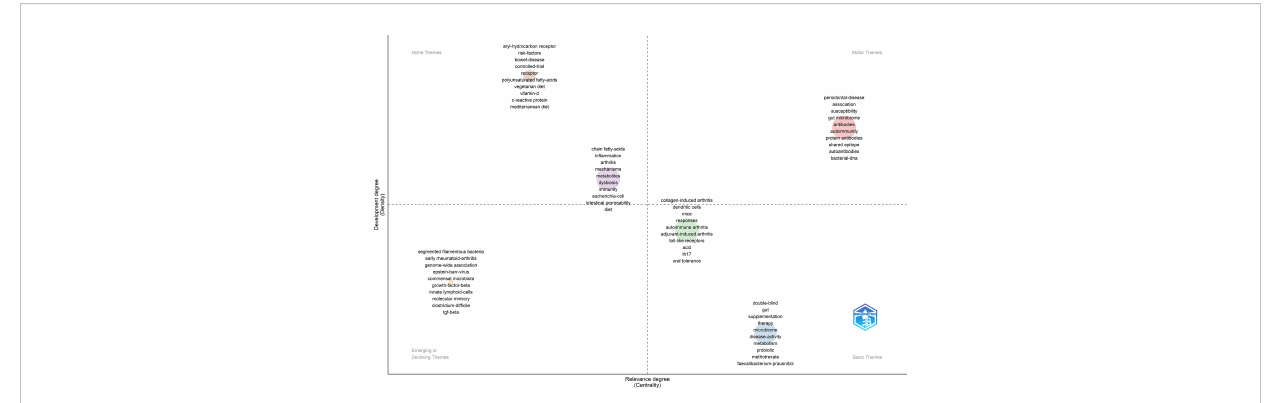
FIGURE 8 The thematic map of the fi eld of GM in